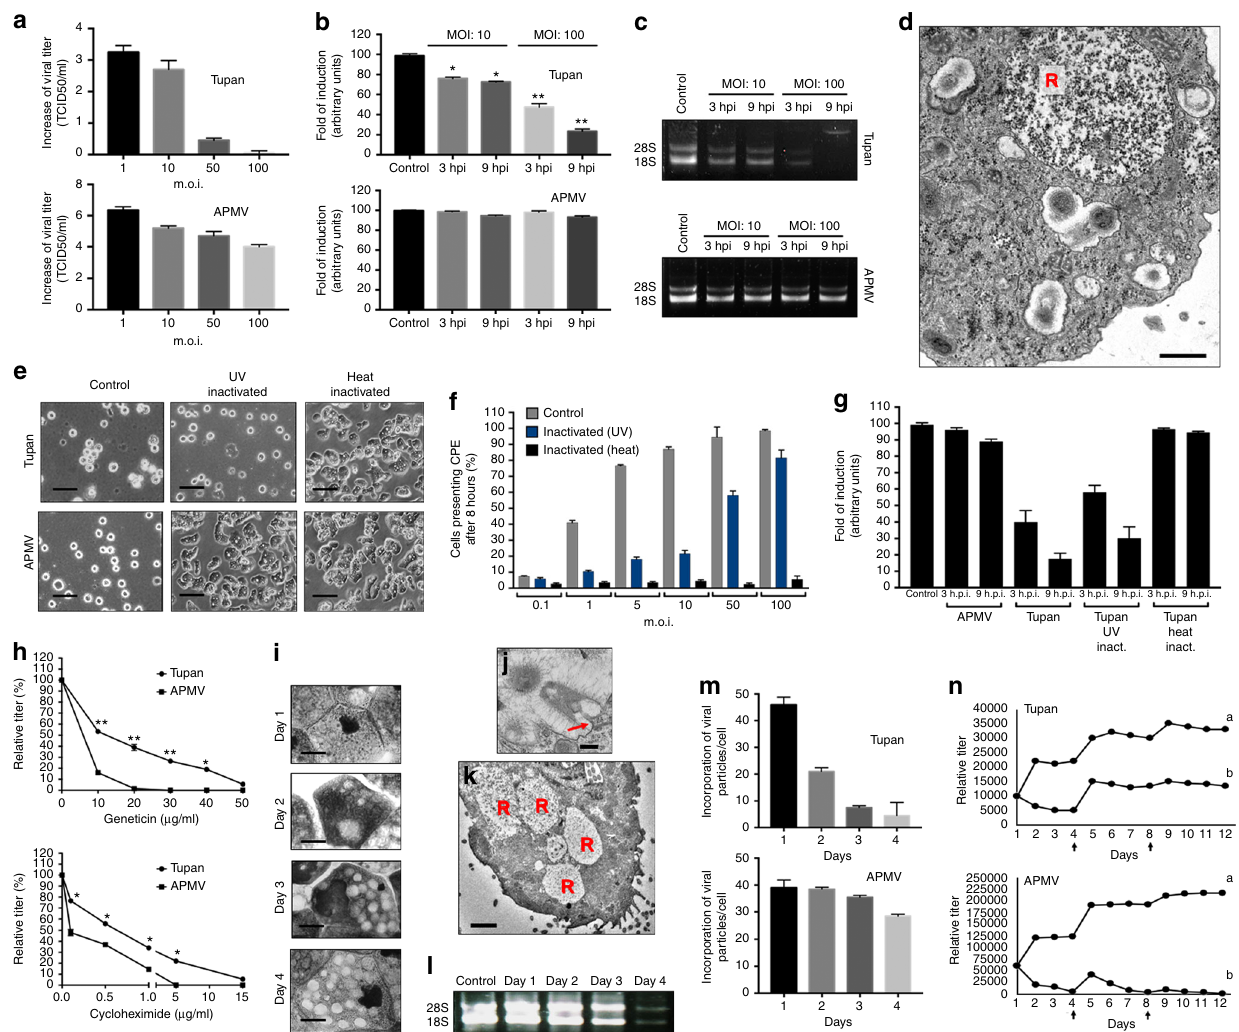
Fig. 8 rRNA shutdown induced by Tupanvirus and toxicity assays. a Tupanvirus and mimivirus titers (log 10 values) 24 h.p.i. in Acanthamoeba castellanii at distinct MOIs. b Ribosomal 18S RNA relative measure by qPCR from A. castellanii infected by tupanvirus or mimivirus at an MOI of 10 or 100, 3 and 9 h post-infection. c Electrophoresis gel showing ribosomal 18S and 28S RNA from A. castellanii under the same conditions described in b . d Vesicle containing a large amount of A . castellanii ribosomes (R) 6 h after Tupanvirus infection. Scale bar, 1 µ m. ( e ) Cytopathic effect of A. castellanii inoculated with Tupanvirus or mimivirus after UV or heat inactivation, MOI of 100, 8 h post-inoculation. Scale bar, 20 µ m. f Counting of A. castellanii presenting cytopathic effect 8 h post-inoculation with tupanvirus inactivated by UV or heating under different MOIs. g Ribosomal 18S RNA relative measure by qPCR from A. castellanii infected by UV-inativated or heat-inactivated Tupanvirus, or APMV, at an MOI of 100, 3 and 9 h post-infection. h Dose – response of Tupanvirus and APMV in A . castellanii pre-treated with distinct doses of geneticin or cycloheximide. ( i ) Progressive vacuolization of tetrahymena after infection with Tupanvirus (days 1 – 4). Scale bars, 10 µ m. j Tupanvirus tail content releasing in tetrahymena 1 h post-inoculation (TEM). Scale bar, 200 nm. k Vesicles containing large amounts of Tetrahymena ribosomes (R) after Tupanvirus infection. Scale bar, 3.5 µ m. l Electrophoresis gel showing rRNA shutdown in tetrahymena inoculated with Tupanvirus at an MOI of 10 (days 1 – 4). m Rate of particles incorporation per tetrahymena cell (days 1 – 4). n Simulations showing the decrease in APMV and maintenance of Tupanvirus populations over the analyzed days after infection of a mix of Acanthamoeba castellanii and tetrahymena at an MOI of 10 (lines indicated by ‘ b ’ in both graphs of n ). At days 4 and 8, fresh PYG medium and 10 5 A. castellanii were added to the systems (arrows). For the negative control of this experiment we pre-treated tetrahymena with 20 µ g/ml of geneticin (lines indicated by ‘ a ’ in both graphs of n ). In this case, both APMV and Tupanvirus were able to grow in the system. Statistical analyses in b and h : t-test based on control groups ( b ) or corresponding virus/drug concentrations ( h ). *: p < 0.05; **: p < 0.01. The experiments were performed 3 times independently, with two replicates each. Error bars ( a , b , f , g , h , m and n ), standard μ g/mL; Mylan, Saint-Priest, France). Each 100 μ L of sample was mixed and were stored in 75cm 2 cell culture fl asks containing 30 mL of peptone yeast extract inoculated in the numbered (1 – 12) wells and incubated at 30 °C in a humid glucose medium (PYG) at 28 °C. After 24 h of growth, cells were harvested and chamber. A negative control was used in each plate. The wells were observed daily pelleted by centrifugation. The supernatant was removed, and the amoebae were under an optical microscope. After 3 days, new passages of the inoculated wells resuspended three times in sterile PAS. After the third washing, 500,000 were performed in the same manner until the third passage. In this passage, the A . castellanii or V . vermiformis were resuspended in PAS or TS solutions and content of the wells presenting lysis and cytopathic effects were collected and seeded in 24-well plates. The amoebae suspensions were added to an antibiotic mix stored for production and analysis of the possible isolates by haemacolour staining containing cipro fl oxacin (20 μ g/mL; Panpharma, Z.I., Clairay, France), vancomycin and electron microscopy using the negative stain technique. Of the twelve tested (10 μ g/mL; Mylan, Saint-Priest, France), imipenem (10 μ g/mL; Mylan, Saint-Priest, samples from Pantanal, we found Tupanvirus (soda lake) in three. In only one France), doxycycline (20 μ g/mL; Mylan, Saint-Priest, France), and voriconazole (20